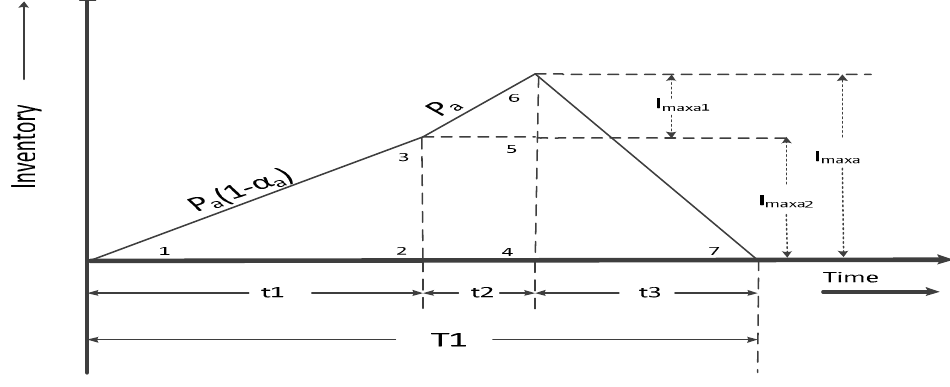
Figure A1. Inventory diagram of the first phase of the manufacturer .